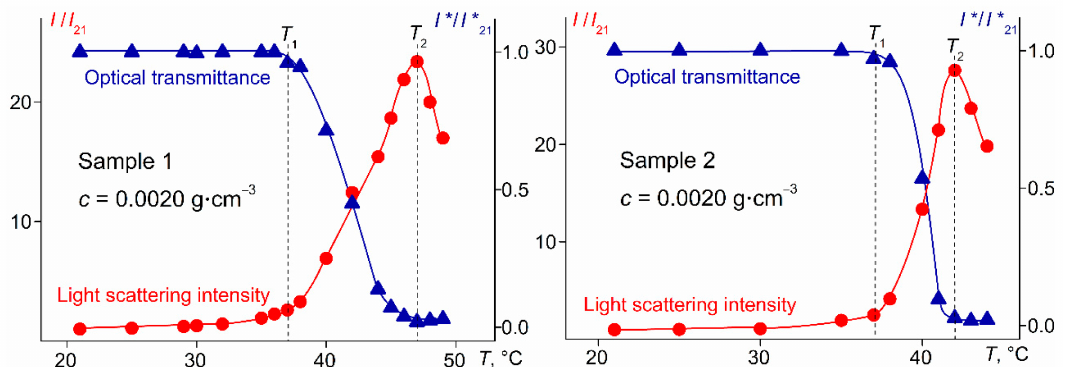
Figure 7. Temperature dependences of relative light scattering intensity I / I 21 and relative transmission I */ I * 21 for solutions of investigated grafted copolymers. I 21 and I * 21 are light scattering intensity and optical transmission at 21 ◦ C, respectively.